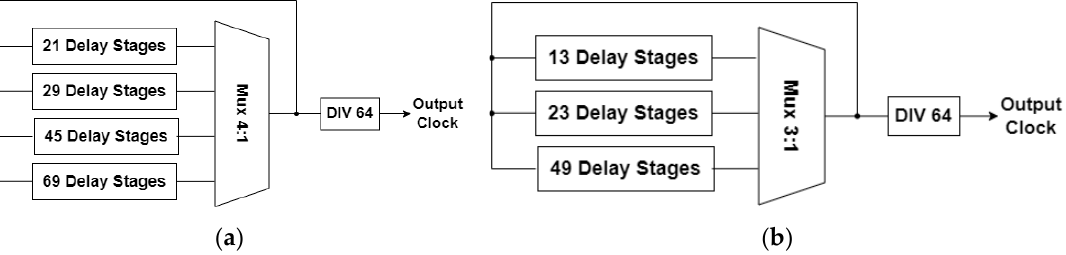
Figure 2. Schematic designs of different gate-based ROs: ( a ) Inverter-based RO schematic design; ( b ) NAND2 or NOR2-gate-based RO schematic design.